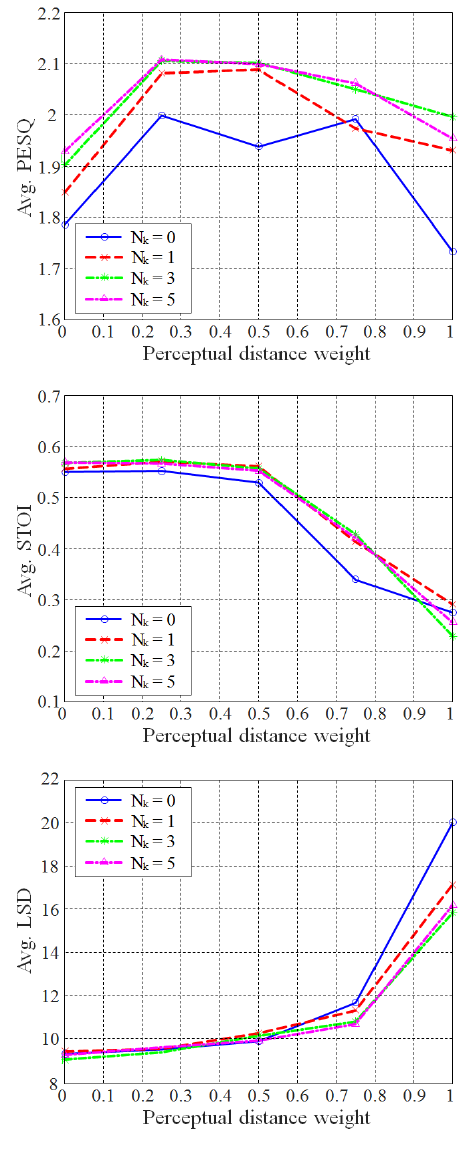
Figure 6. Objective evaluation results for the various perceptual distance weights and the taps of the HE filters ( N k ). ( Top ): Average PESQs. ( Middle ): STOIs. ( Bottom ):